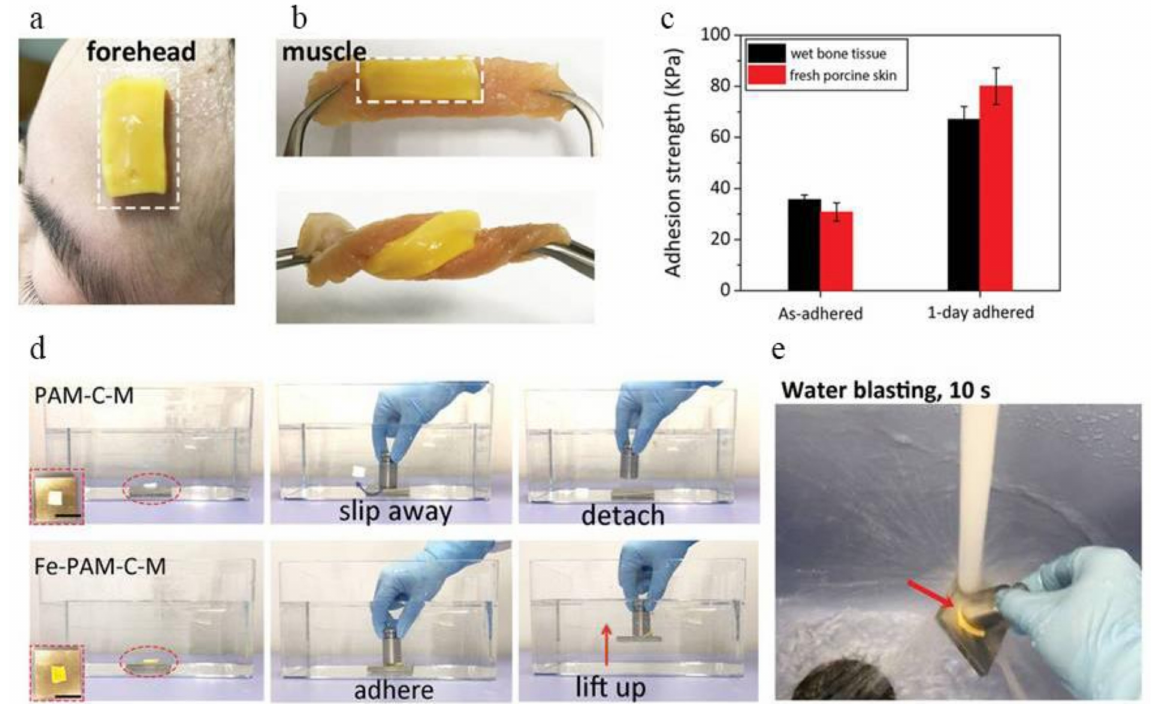
Figure 9. Wet tissue adhesiveness of Fe 3+ -polyacrylamide-hydrophobic stearyl methacrylate-N,N (cid:48) -methylenebisacrylamide (Fe-PAM-C-M). ( a ) Photographs showing that the Fe-PAM-C-M hydrogel readily adhered to the forehead of one of the authors after perspiring. The humidity of the skin is higher than 120%. The size of the hydrogel applied on the skin is 10 mm in width, 20 mm in length, and 2 mm in thickness. ( b ) Photographs of a Fe-PAM-C-M hydrogel adhered to porcine muscle. No detachment or crack was observed between the hydrogel and tissue regardless of distortion. ( c ) The wet adhesion strength of Fe-PAM-C-M to porcine skin and bone tissues. The preload and contact time for tissue adhesion experiments are 5 kPa and 120 s. ( d ) Demonstration of underwater adhesion. The as-prepared hydrophilic PAM-C-M hydrogel was non-adhesive and slipped away from the metal block surface underwater, while the hydrophobic Fe-PAM-C-M hydrogel firmly adhered to the metal block surface and was able to lift the block (200 g) up underwater. ( e ) Photograph showing that the adhesion between the hydrogel and substrate is strong enough to resist water blasting for 10 s